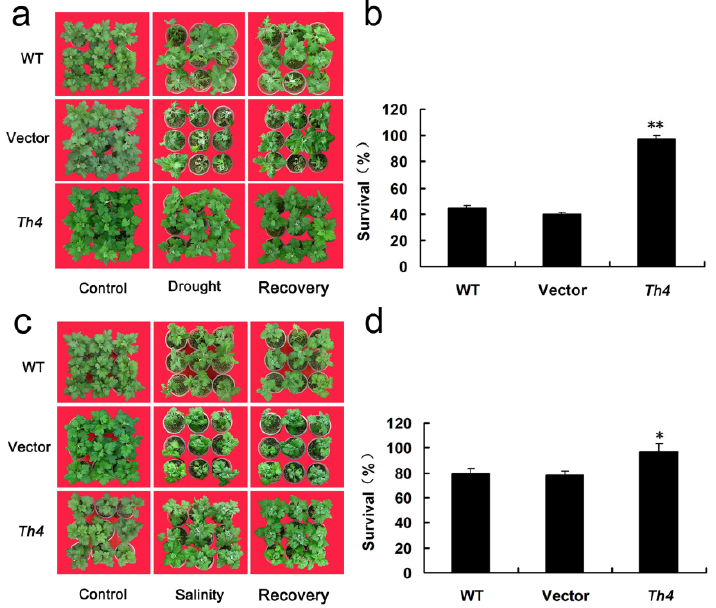
Figure 7. The drought and salinity tolerance of transgenic chrysanthemum. ( a ) The appearance of WT, EV and Th4 plants subjected to a 24 days period of no watering, and during the recovery period; ( b ) The survival rate of WT, EV and Th4 after a two-week recovery period. Error bars based on three replicates. Mean performances differing significantly from the WT and EV performance, as derived from a Tukey’s test, indicated by asterisks (** p < 0.01); ( c ) The appearance of WT, EV and Th4 plants subjected to salinity stress and during the recovery period; ( d ) The survival rate of WT, EV and Th4 after a two-week recovery period. Error bars are based on three replicates. Mean performances differing significantly from the WT and EV performance, as derived from a Tukey’s test, indicated by asterisks (* p <